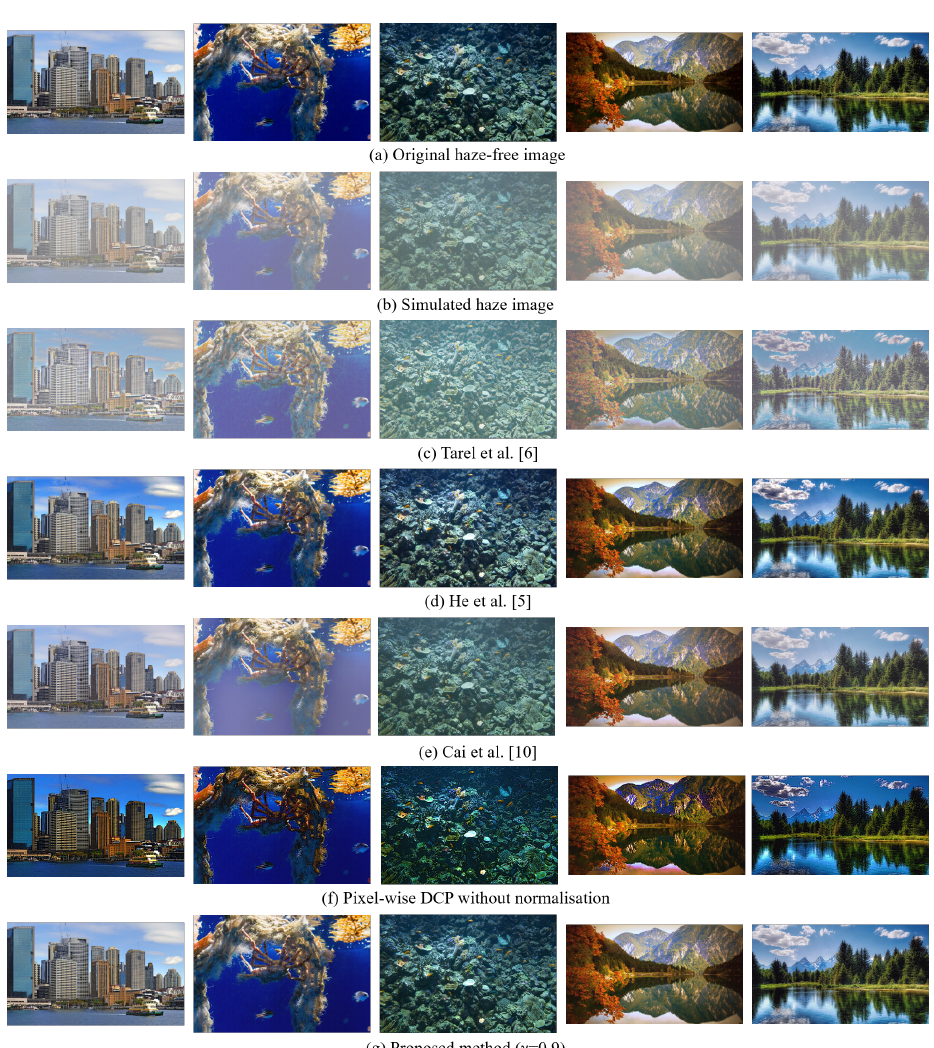
Figure 7. Comparison of proposed method with conventional method using simulated haze images generated with uniform transmission map ( t = 0.5). ( a ) Original haze-free image, ( b ) Simulated haze image, ( c ) Tarel et al. [6], ( d ) He et al. [5], ( e ) Cai et al. [10], ( f ) Pixel-wise DCP without normalisation, ( g ) Proposed method ( γ =